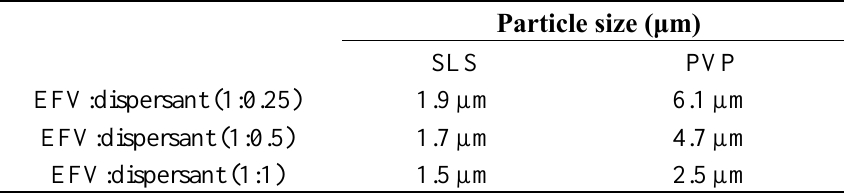
Table 1. Average particle size, measured